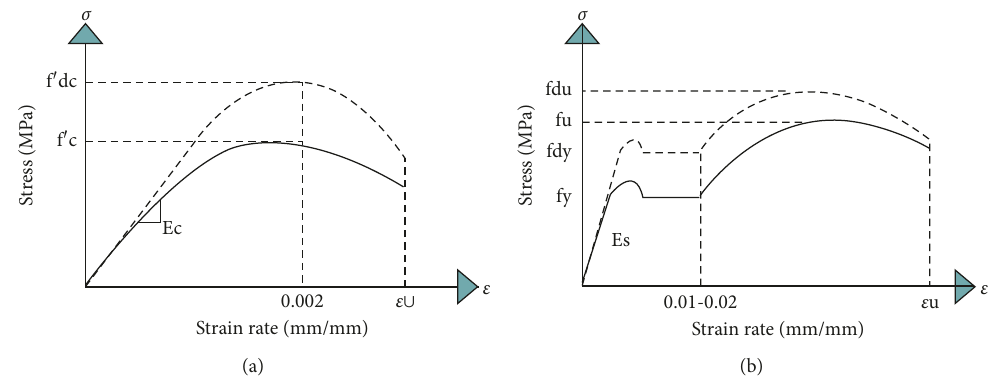
Figure 5: Stress-strain curves: (a) concrete and (b) reinforcing steel.